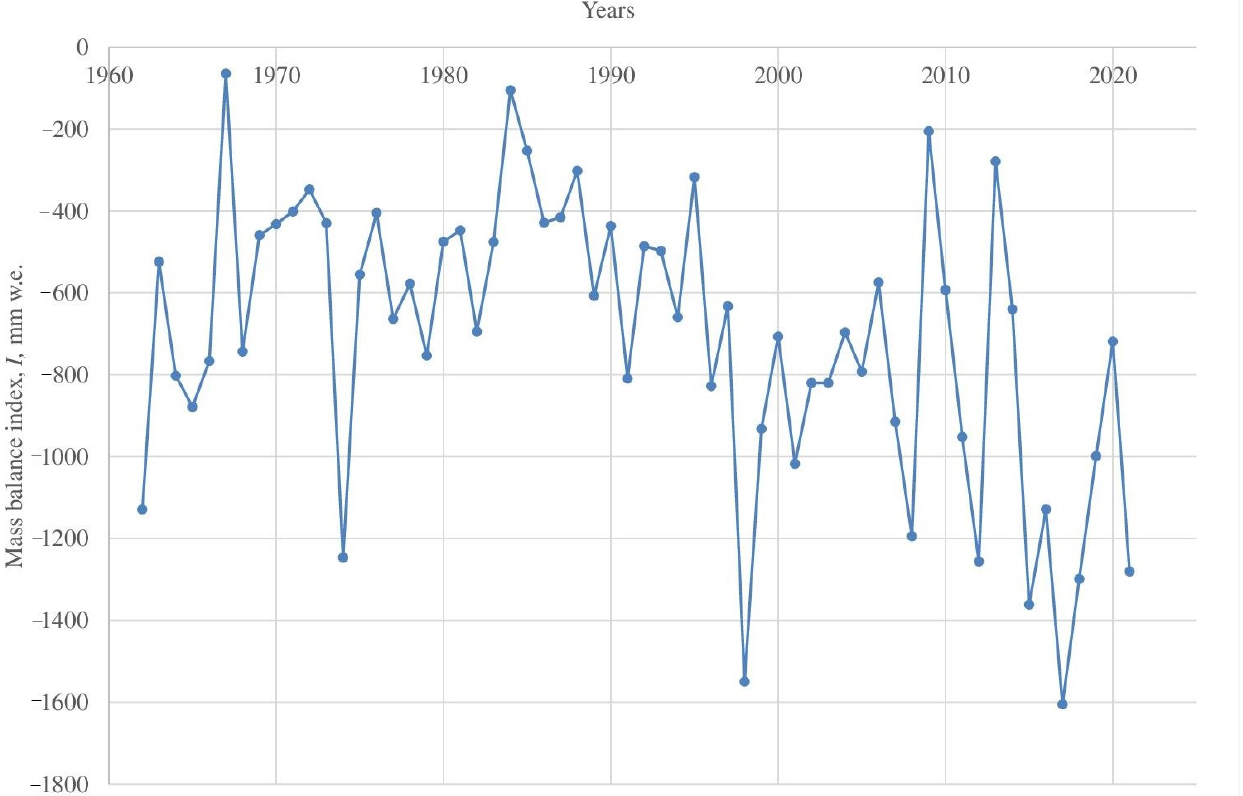
Figure 18. Changes in the mass balance index at the present ELA of the Maashei glacier (2890